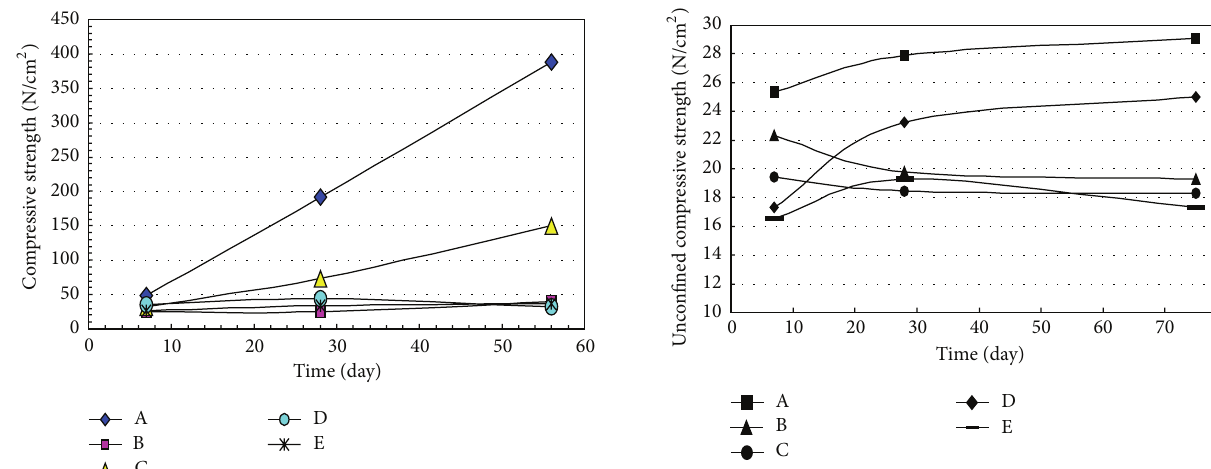
Figure 8: Strength development of lime cubes.